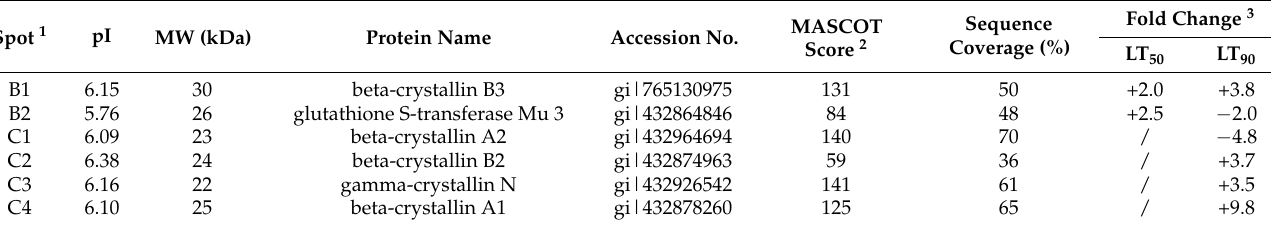
Table 2. Differential protein spots with at least two-fold differences exclusively found in 2-DE images of Karenia -exposed medaka collected at LT 50 and/or LT 90 compared with untreated medaka.